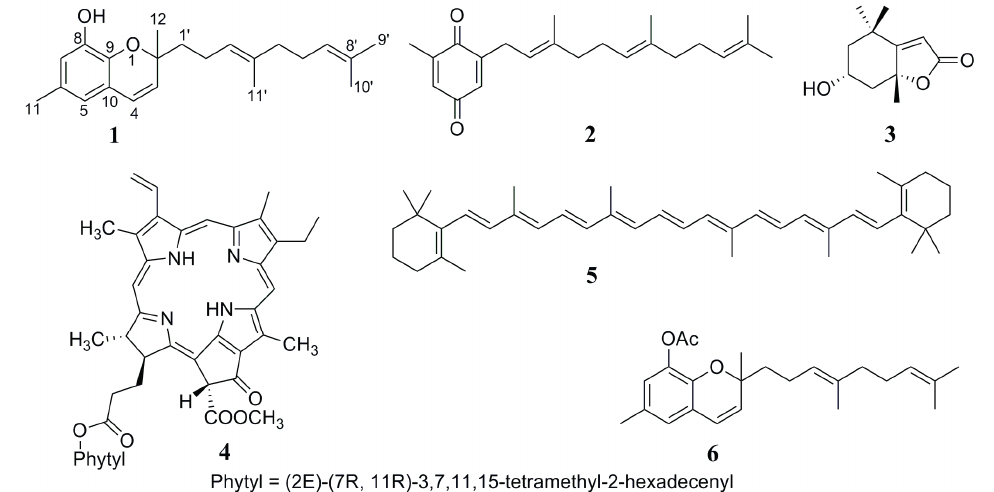
Chart 1. Structures of metabolites 1 – 6